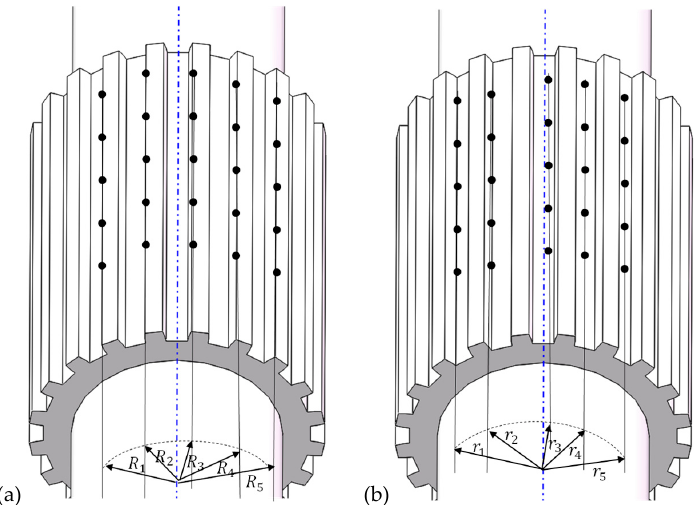
Figure 9. Measuring method for basis parameters of the splined section: ( a ) outside diameter, ( b ) root diameter.